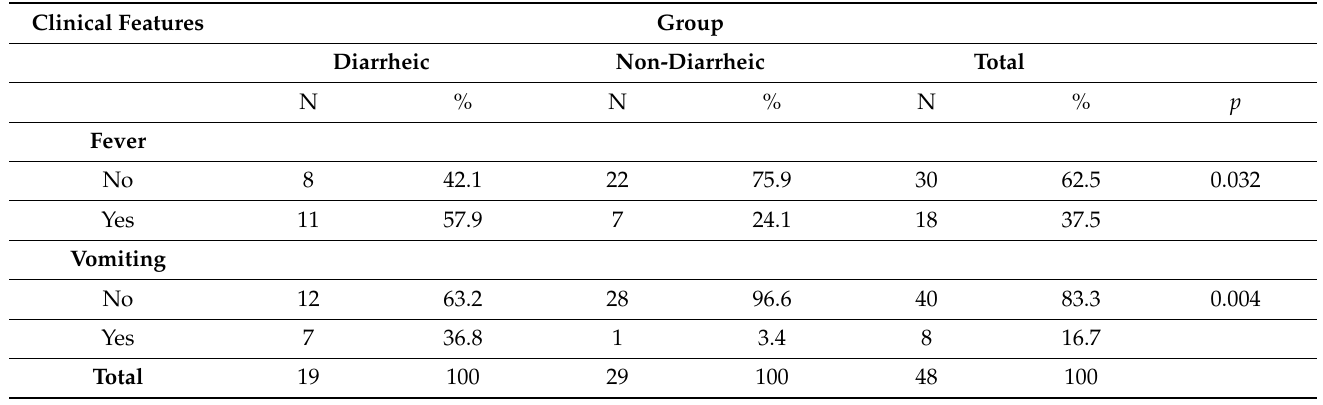
Table 2. Clinical major symptoms observed in children infected with HBoV from Acre State, Brazil,